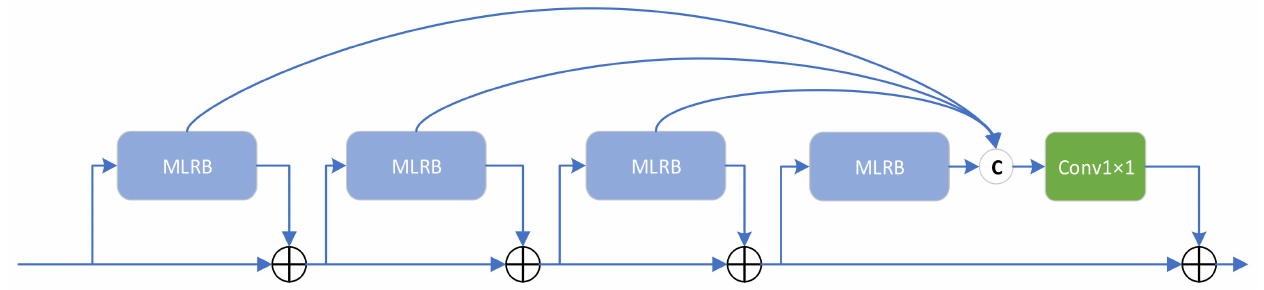
Figure 4. Detailed structure diagram of continuous residual aggregation block